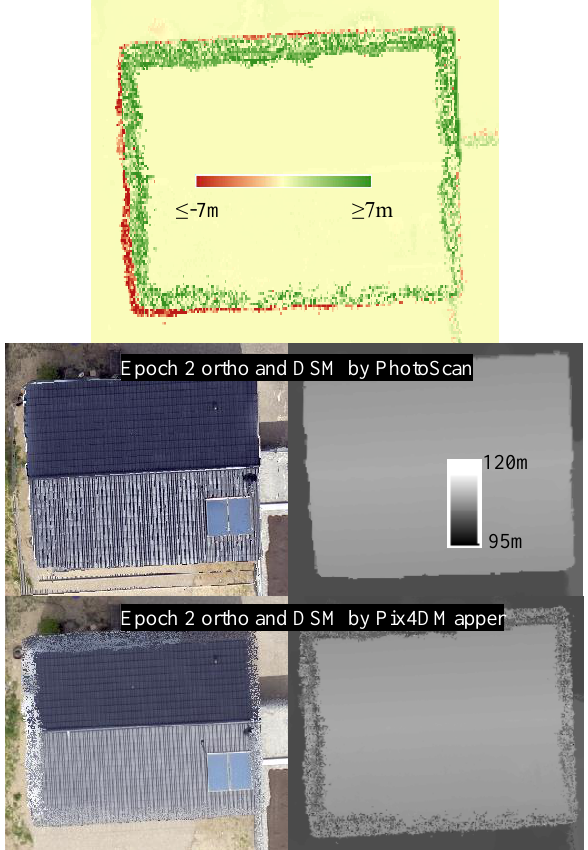
Figure 12: DSM difference PhotoScan minus Pix4DMapper and corresponding orthophotos and